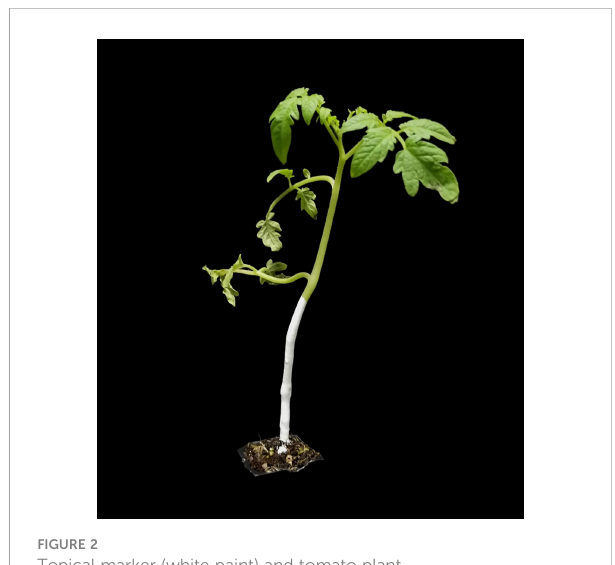
FIGURE 2 Topical marker (white paint) and tomato